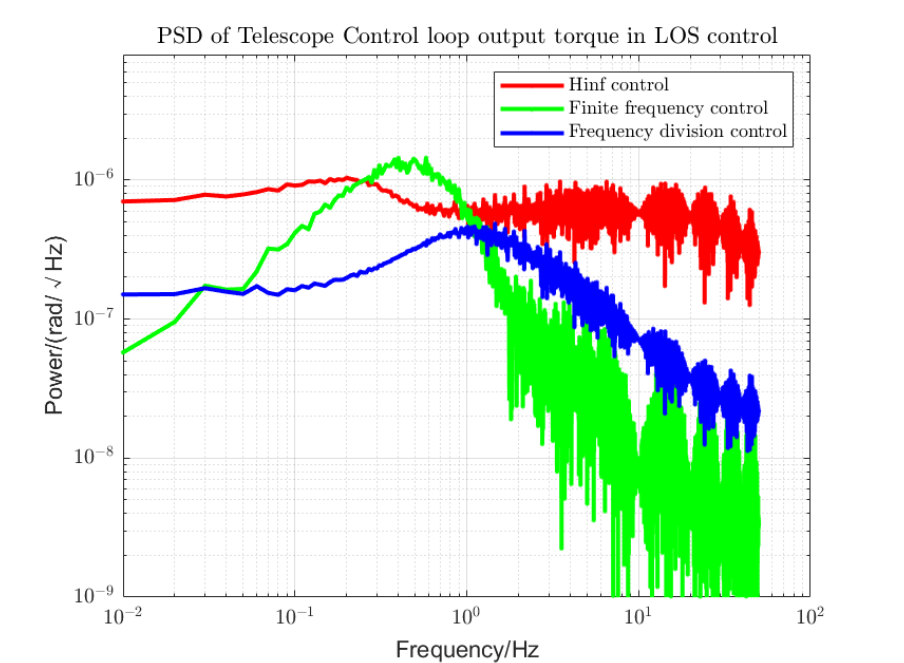
Figure 7. PSD of telescope Control loop output torque. The control performances of the loop-shaping H-infinity control, finite frequency control, and frequency division control are